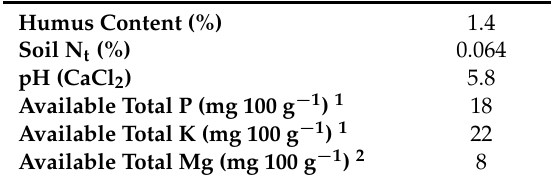
Table 1 . Soil characteristics (30 cm depth) of the experimental site. Table 1. Soil characteristics (30 cm depth) of the experimental site.